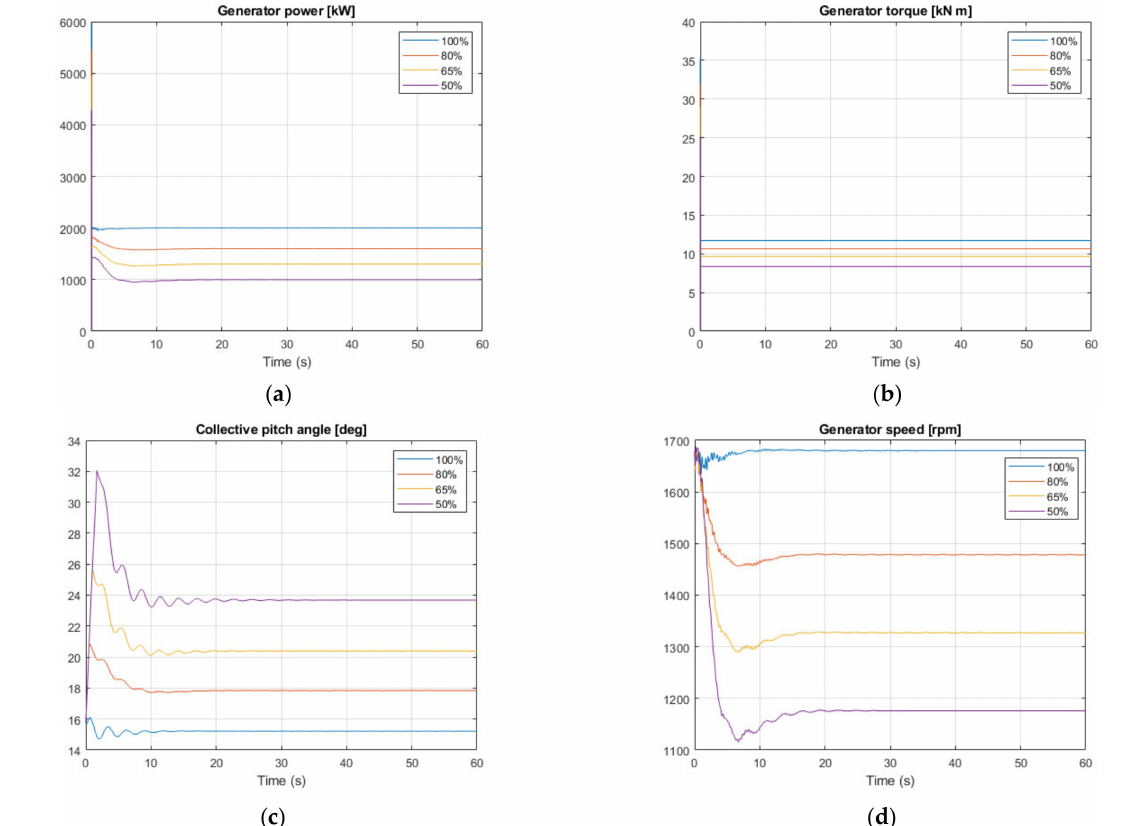
Figure 10. Simulation responses with different power limitations: ( a ) generator power; ( b ) generator torque; ( c ) collective pitch; ( d ) generator